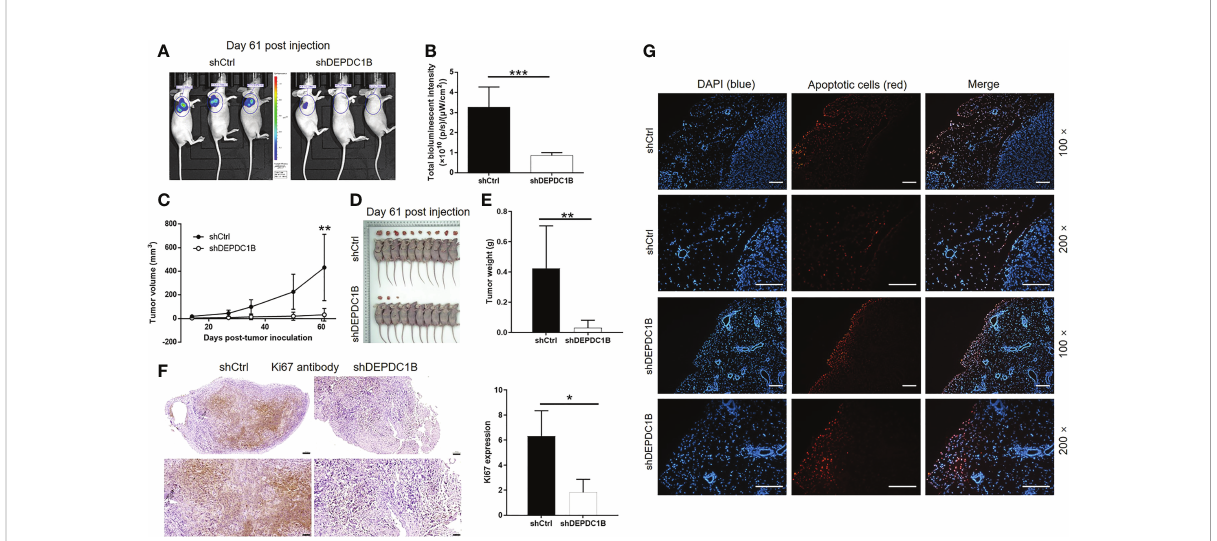
FIGURE 3 DEPDC1B knockdown inhibited CCA development in vivo . (A, B) In vivo imaging was performed to evaluate the tumor burden in mice of shDEPDC1B and shCtrl groups at day 61 post tumor inoculation. (C) Fourteen days post injection of HUCCT1 cells with or without DEPDC1B knockdown, the volume of tumors formed in mice was measured and calculated at indicated time intervals. (D, E) Mice were sacri fi ced at day 61 post injection, and the tumors were removed for collecting photos (D) and weighing (E) . (F) The expression of Ki67 in sections of xenografts was detected by IHC analysis (scale bar = 100 m m). (G) TUNEL analysis was performed in xenografts of shDEPDC1B and shCtrl groups (scale bar = 200 m m). Data were shown as mean ± SD (n = 3). * P < 0.05, ** P < 0.01, *** P <